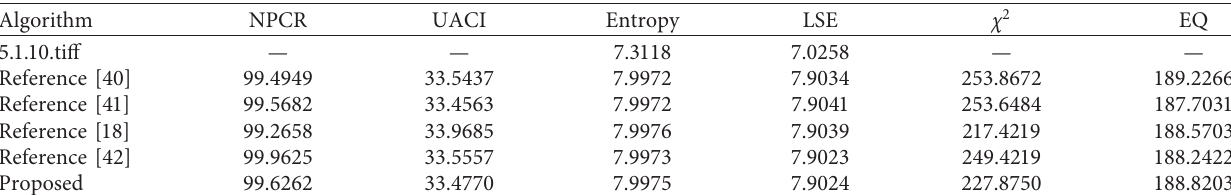
Table 16: Comparison